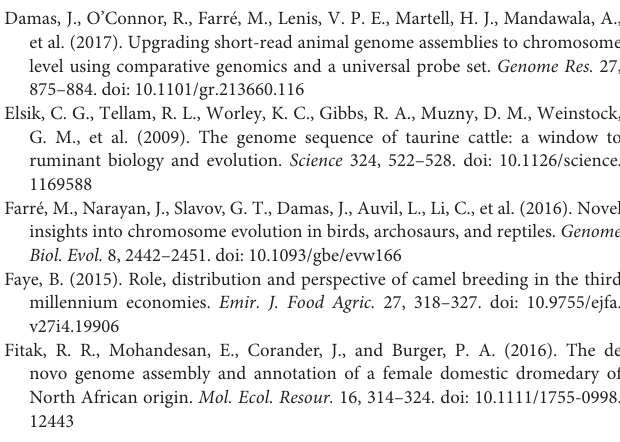
TABLE S4 | Assessment of the quality of the new assembly using